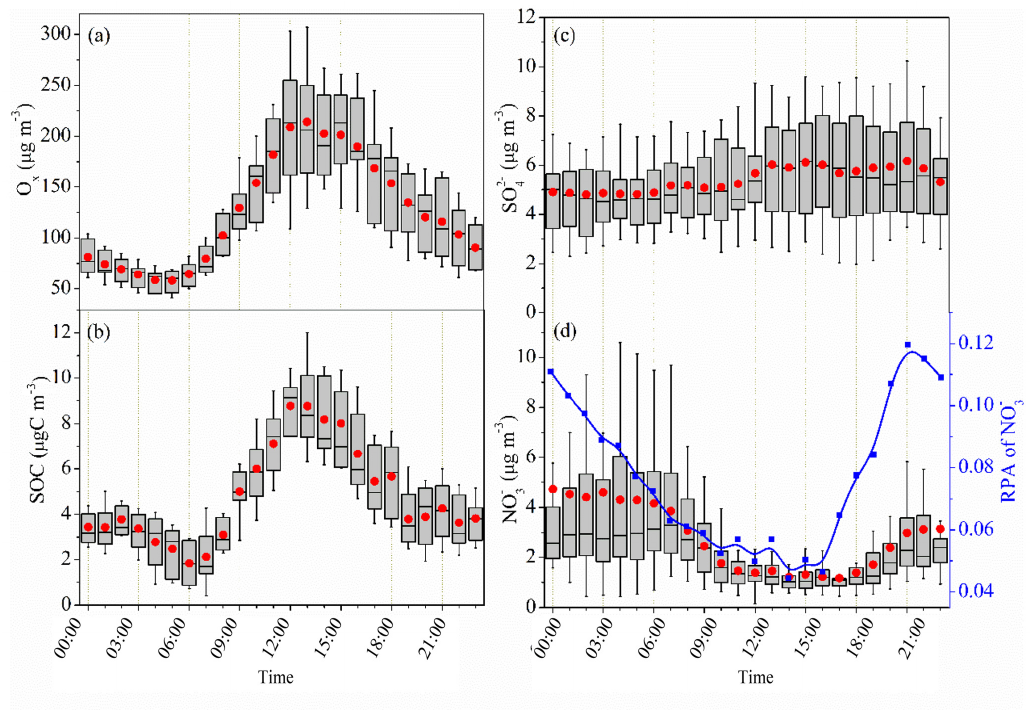
Figure 8. Averaged diurnal variations in O x , SOC, SO 2 − in (d) is daily variation in relative peak area of NO −